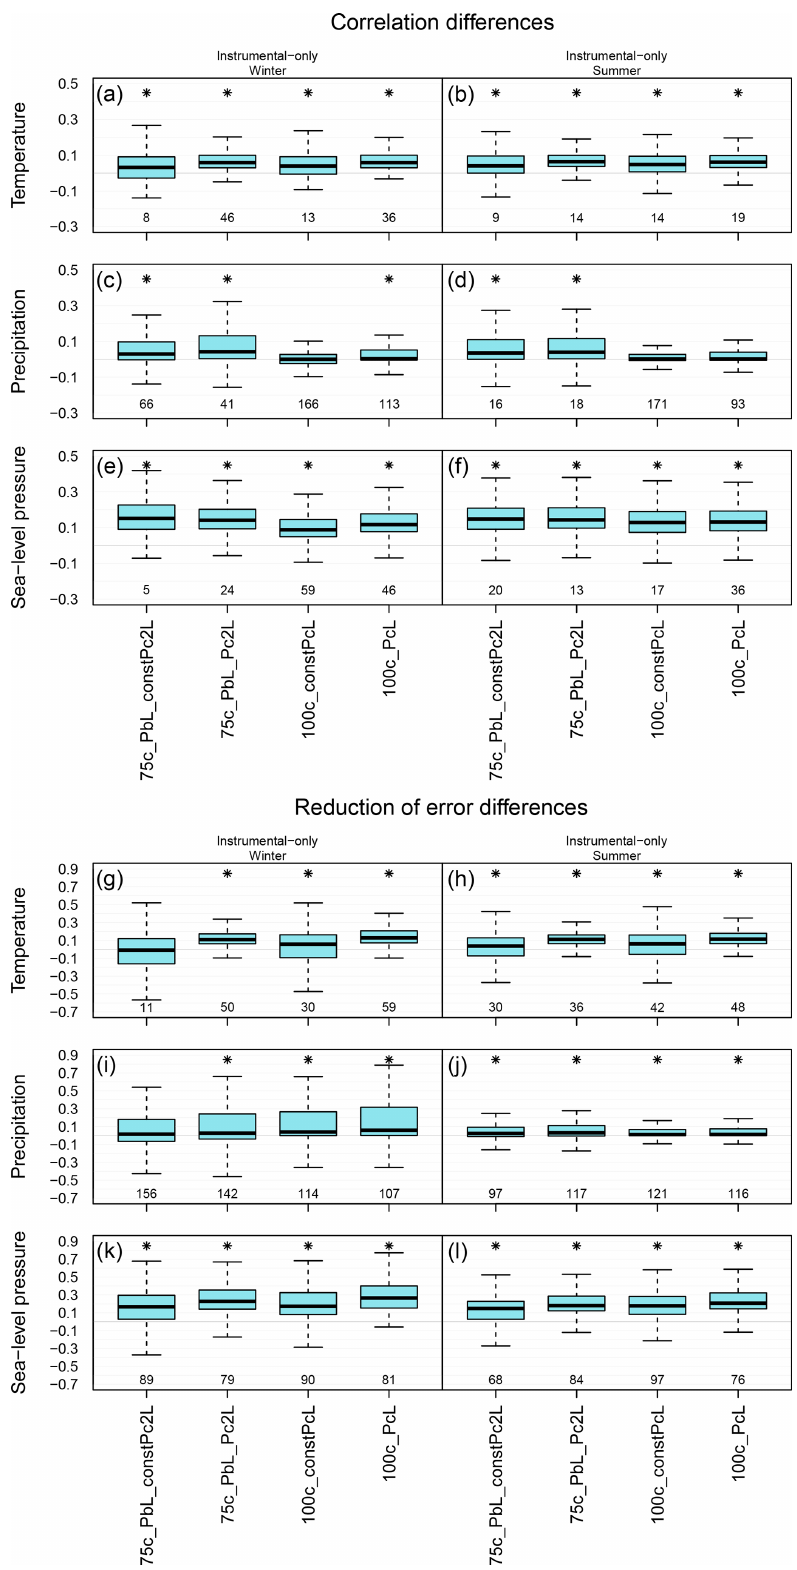
Figure 8. Distribution of skill scores over the ENH region. The skill of the original setup is compared with experiment 75c_PbL_constPc2L, 75c_PbL_Pc2L, 100c_constPcL and 100c_PcL. Distribution of correlation coefficients in the winter (left column) and in the summer (right column) seasons. Distribution of RE values in the winter (left column) and in the summer (right column)